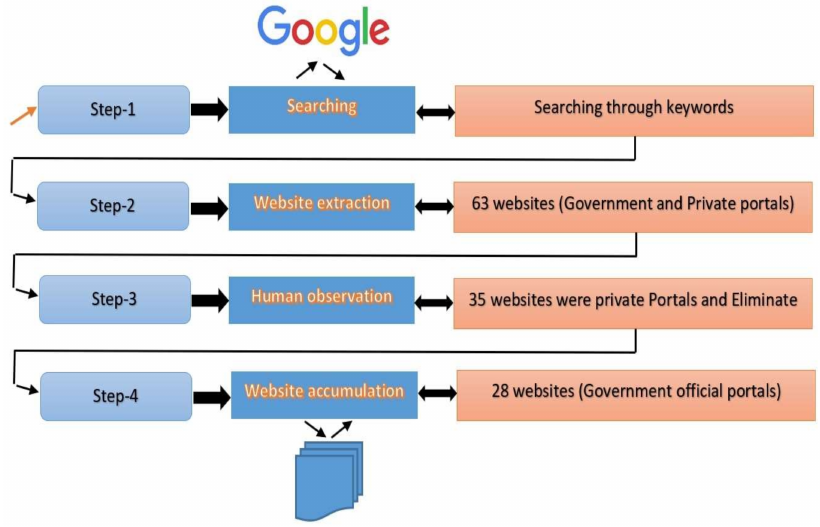
Figure 3. Websites selection for accessibility